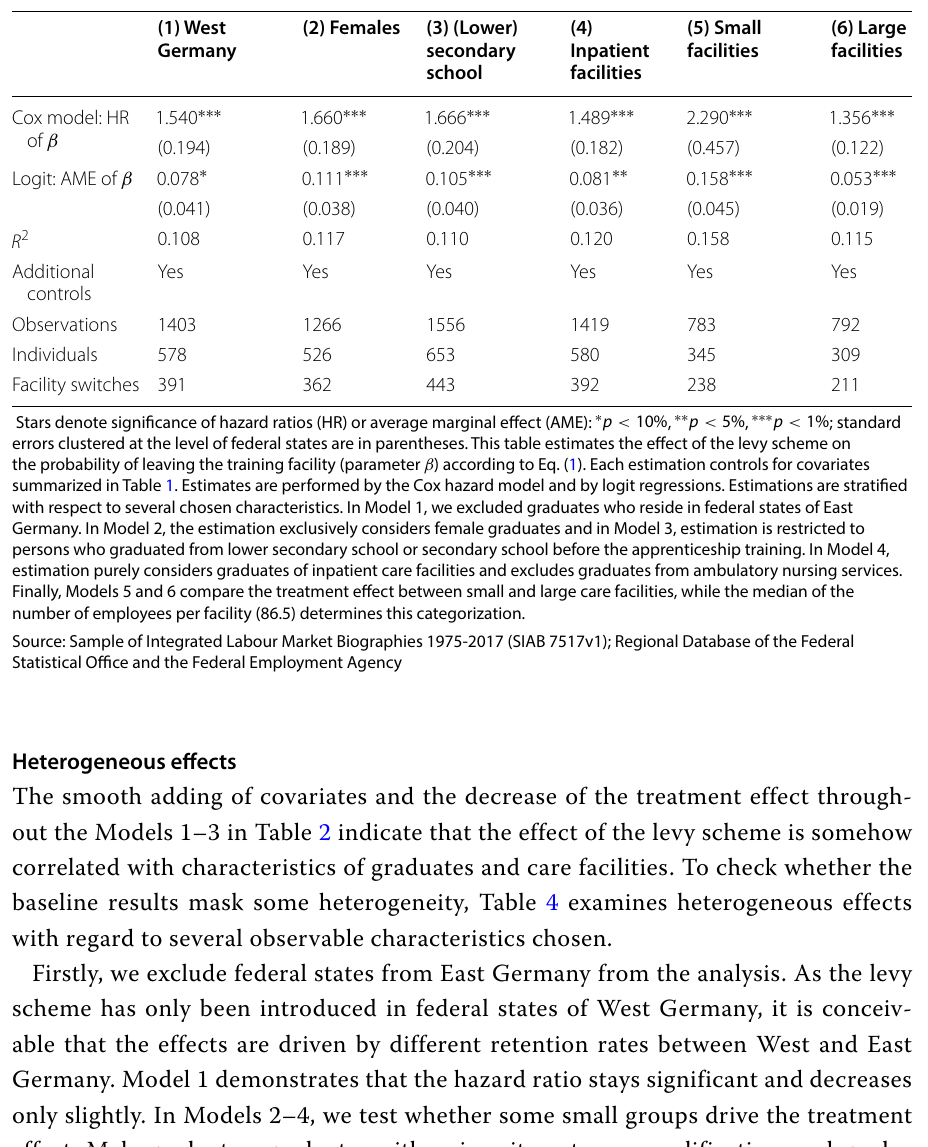
Table 4 Heterogeneous